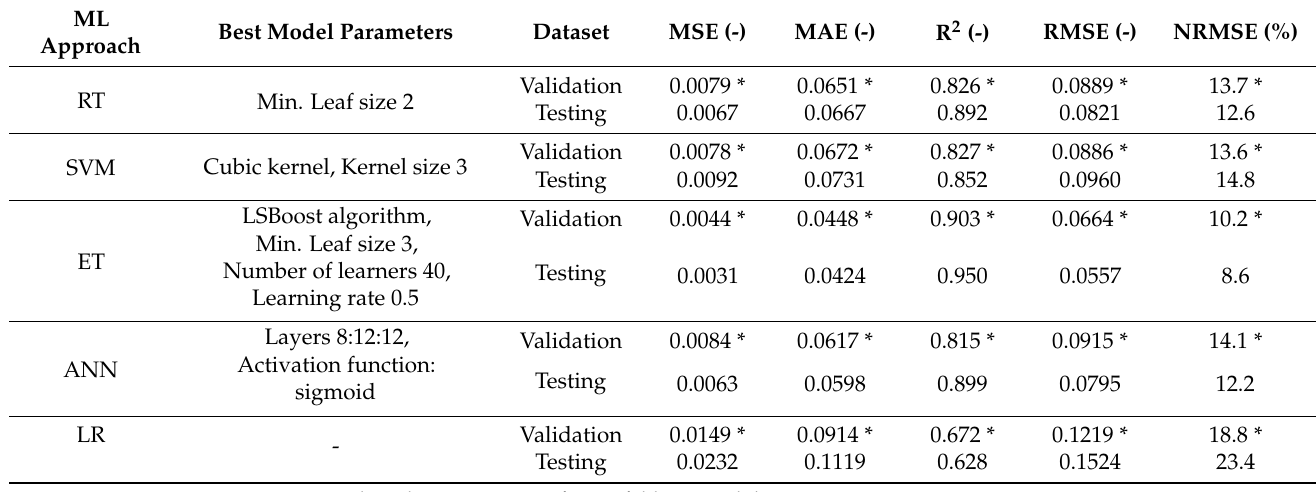
Table 5. Performance of the most accurate models for each ML approach.